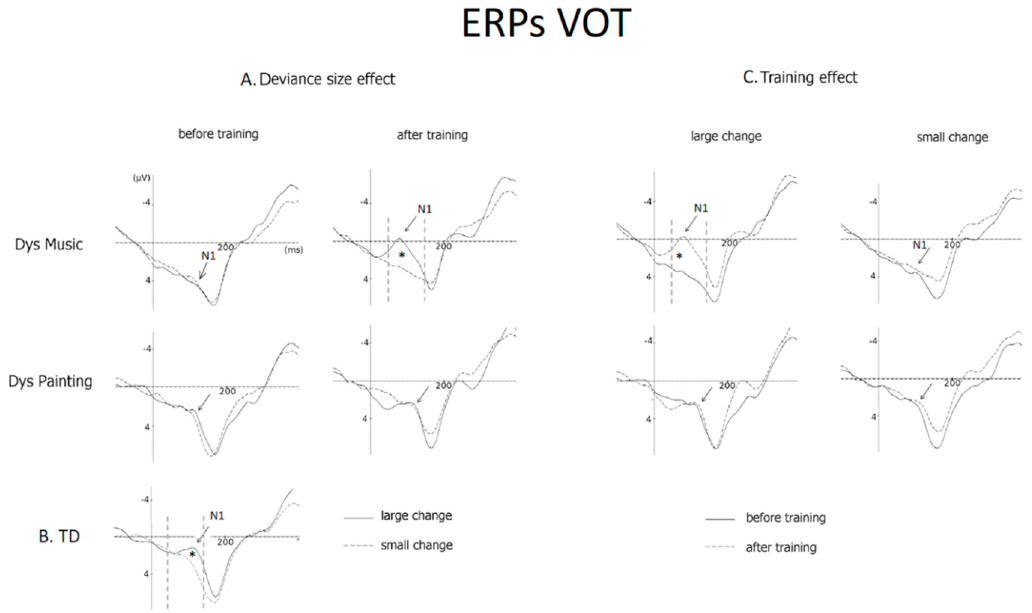
Figure 4. ERPs (original averages) to VOT deviant stimuli at Fz. ( A ) The deviance size e ff ect (i.e., ERPs to large and small deviant stimuli) is illustrated before and after training for children with dyslexia trained with music (DysMus, top) or with painting (DysPaint), middle) and ( B ) for Typically Developing children (TD). ( C ) The training e ff ect to large and small changes in VOT is illustrated before (solid lines) and after training (dashed line) for children with dyslexia in the music and in the painting groups.